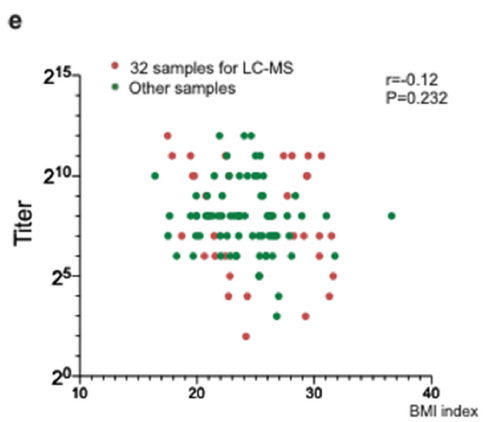
Figure 1. The humoral response of the enrolled patients and the influence of different factors. ( a ) The anti − RBD neutralizing titer in all enrolled participants. ( b ) The anti − RBD total antibody and IgG concentration in all enrolled participants. ( c ) The anti − RBD neutralizing titer in 106 participants collected 14 − 28 days post vaccination according to sex. ( d ) The correlation of the anti − RBD neutralizing titer and age. ( e ) The correlation of the anti − RBD neutralizing titer and BMI.